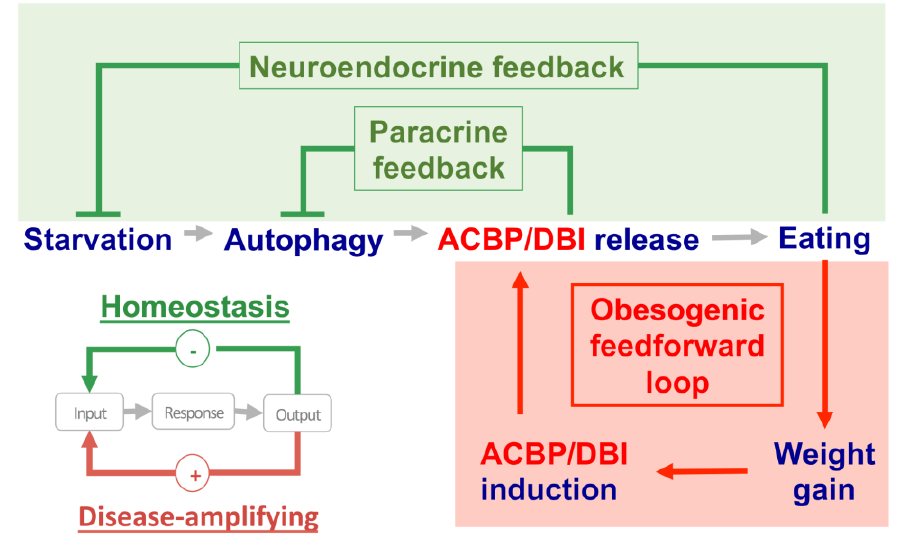
FIGURE 3: Hypothetical involve- ment of the appetite-stimulatory effects of ACBP/DBI-in two distinct circuitries: (i) an acute neuroendo- crine feedback loop that is activat- ed by starvation or fasting